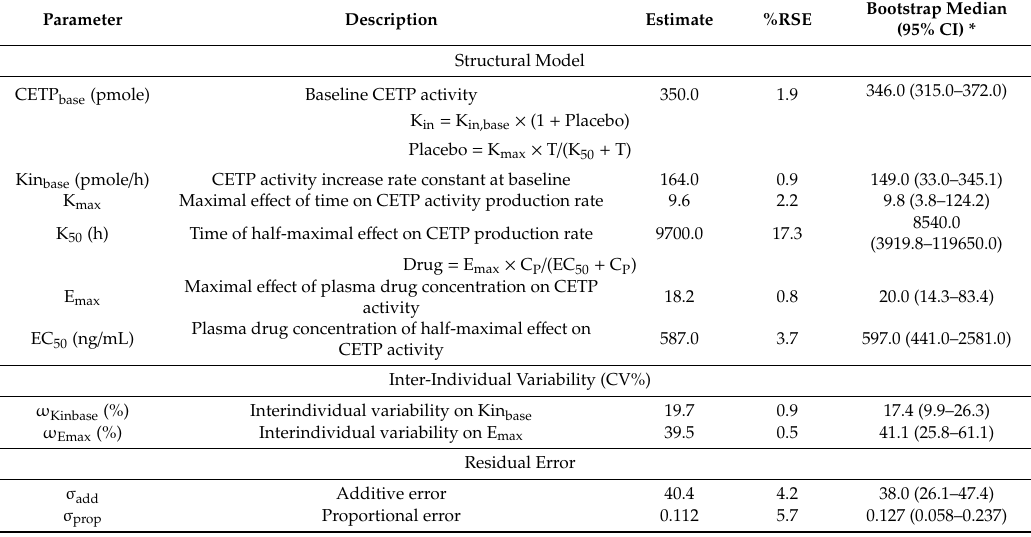
Table 3. Parameter estimates for CETP